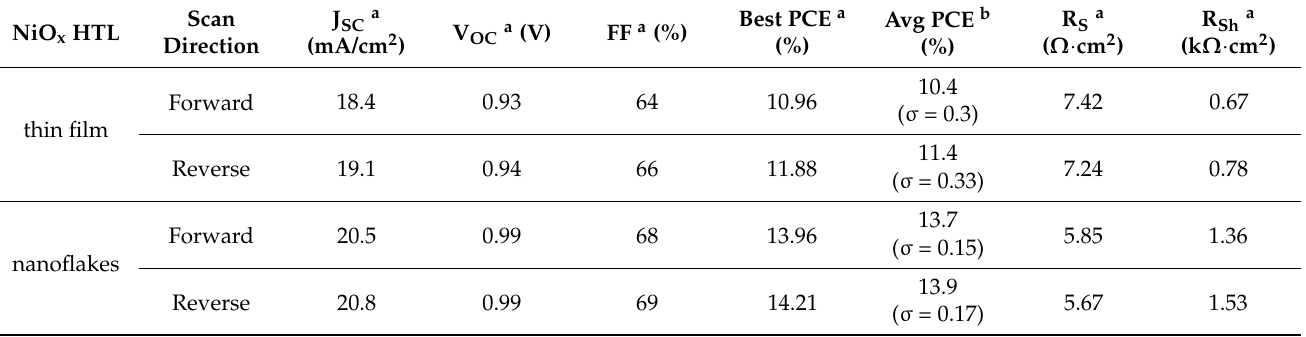
Figure 10. ( a ) Energy level diagram, ( b ) J–V characteristics, ( c ) EQE spectra and integrated current density, and ( d ) normalized PCE evolution of devices based on the NiO x thin film and nanoflakes. Table 1. Device performance of inverted PSCs based on different NiO x Table 1. Device performance of inverted PSCs based on different NiO x HTLs.